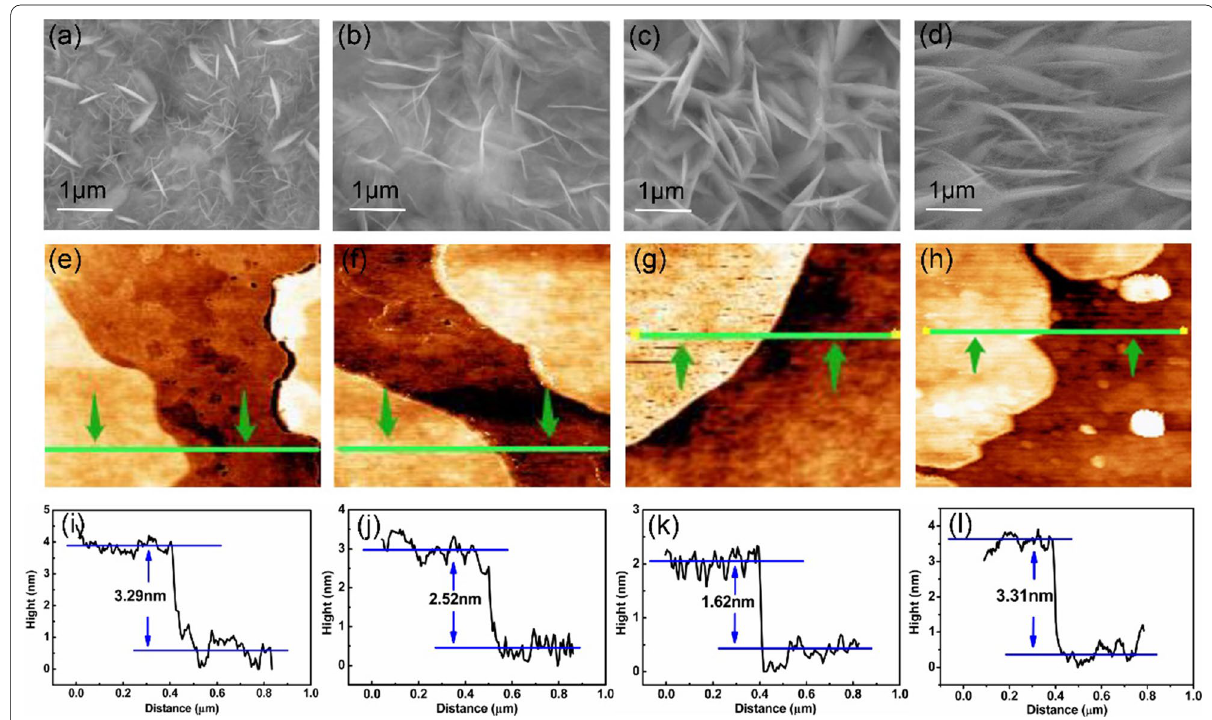
Fig. 1 a – d SEM images of the samples: a NiCo-LDH-3, b NiCo-LDH-2, c NiCo-LDH-1, d NiCo-LDH-0; e – h AFM images of the sample: e NiCo-LDH-3, f NiCo-LDH-2, g NiCo-LDH-1, h NiCo-LDH-0; i – l the thicknesses of the samples: i NiCo-LDH-3, j NiCo-LDH-2, k NiCo-LDH-1, l